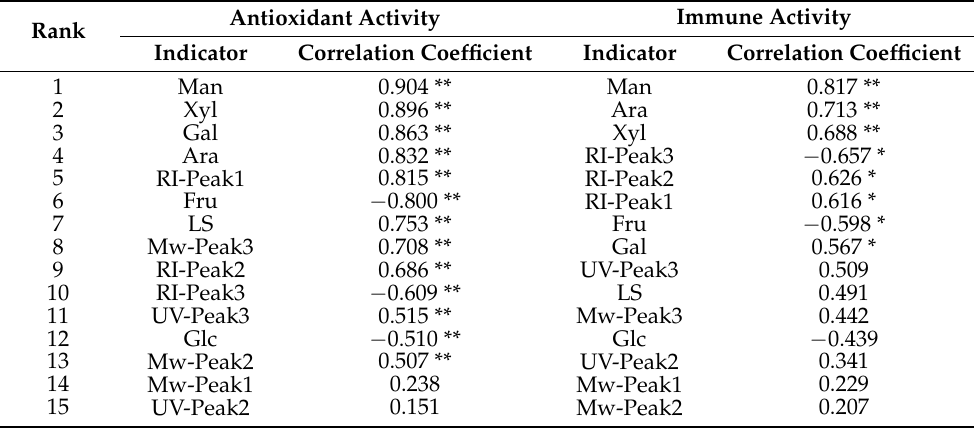
Table 5. Pearson correlation analysis between activities and physicochemical characters. Antioxidant Activity Immune Activity Rank